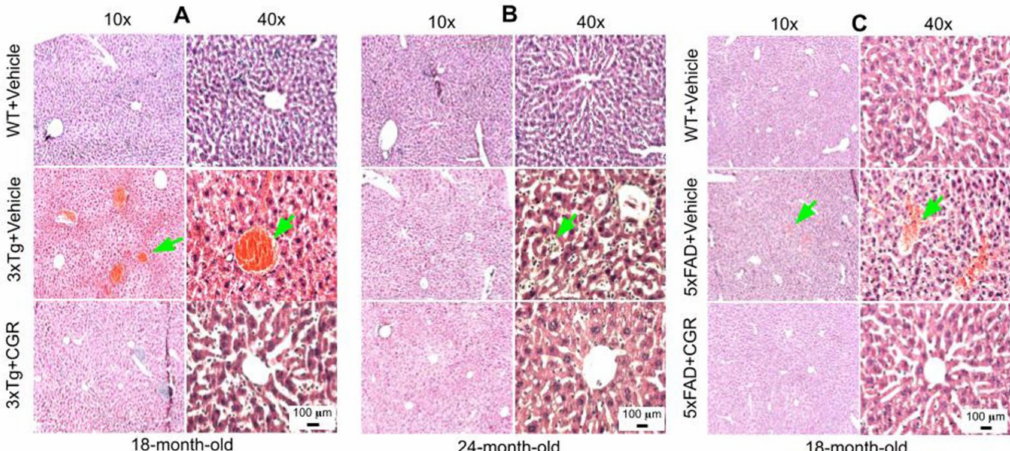
Figure 5. Liver morphology was improved by CGR treatment in both 3xTg and 5xFAD mice. Triple transgenic AD mice, 5xFAD, and age-matched WT mice were treated with CGR (100 mg/kg) for 2 months and the mice were perfused with PBS and fixed with 4% paraformaldehyde and the liver was dissected out, embedded with paraffin, and section at 5 µ m, and stained with hematoxylin and eosin (H&E) stains and the images were taken by compound light microscope using either 10 × or 40 × objectives (total magnification = 100 × or 400 × ). ( A – C ) Representative images of liver morphology from 3xTg mice from 18-month-old ( A ), 24-month-old ( B ) and 18-month-old 5xFAD mice ( C ) after treatment with CGR. A significant degeneration of liver central vein (green arrows) and lobules, as well as infiltrations were observed in both 3xTg and 5xFAD mice liver tissue and treatment with CGR ameliorated these changes. Scale bar = 50 µ m and is applicable to all other